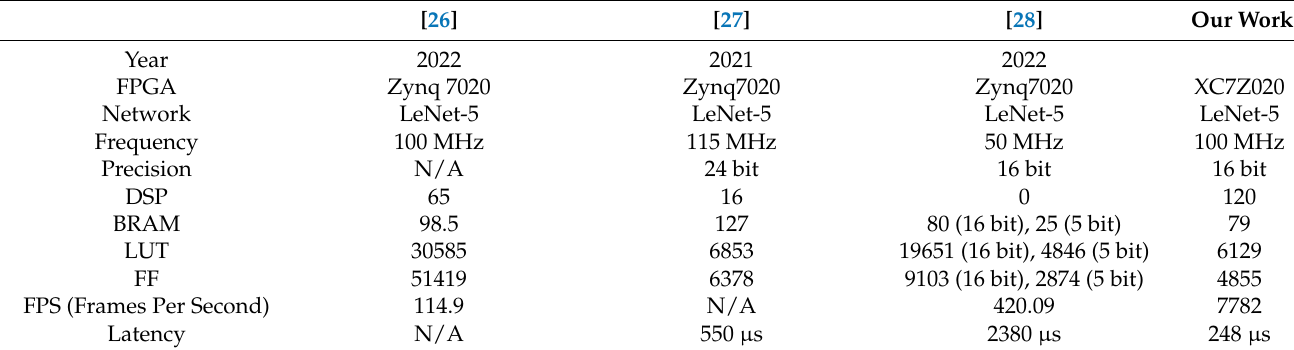
Table 4. Comparison with the previous